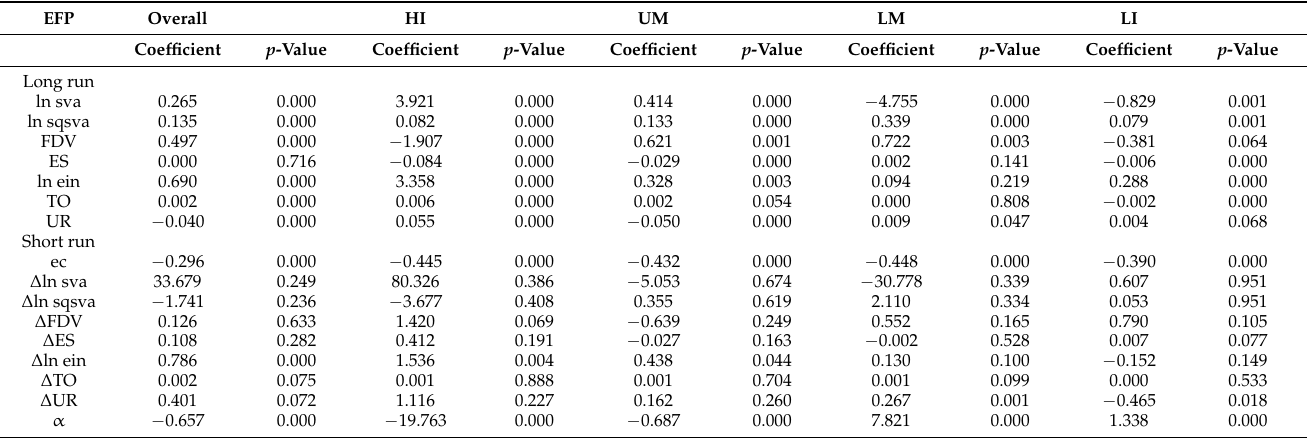
Table 10. The impact of the service sector (sva) on